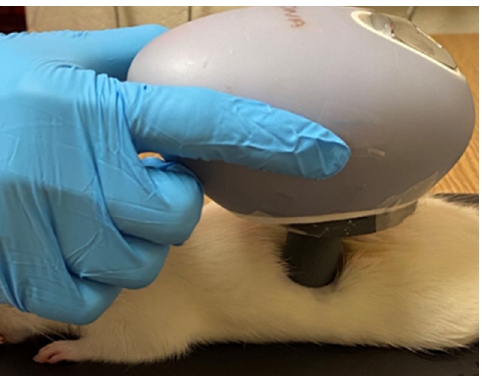
Figure 3. Representative image showing the placement of the nozzle of DMTD on top of the skin surrounding the infection site for delivery of CMS onto the third infected wound on a rat’s back.